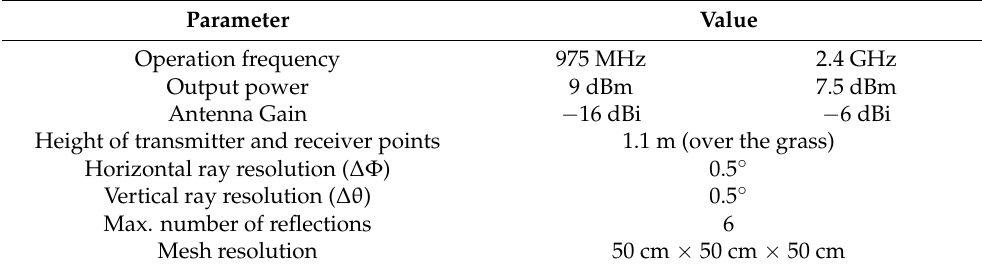
Table 2. Parameter configuration for the simulations using the 3D-RL tool.